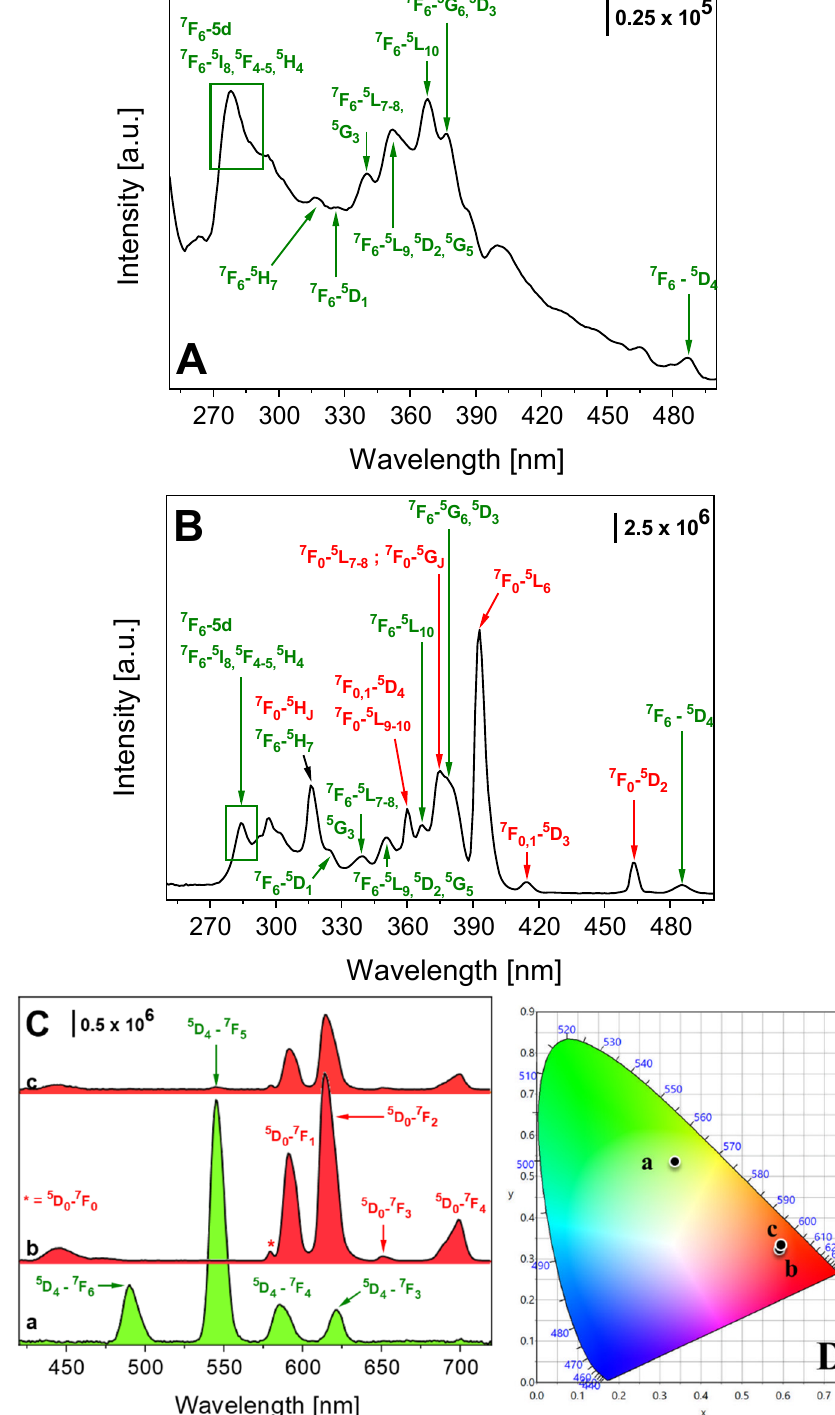
Figure 4. Excitation spectra at solid-state of TbEu-PhPOSS monitored at λ em = 545 nm ( A ) and λ em = 615 nm ( B ). ( C ) Emission spectra at solid-state of Tb-PhPOSS (a, λ exc = 285 nm) and TbEu-PhPOSS (b, λ exc = 395 nm, c, λ exc = 285 nm). The electronic transitions of terbium are marked in green colour, while those assigned to europium are in red, for more clarity. ( D ) CIE 1931 xy chromaticity diagrams derived from emission spectra in frame ( C ). The colour of each emission spectrum in frame ( C ) is associated with its corresponding xy coordinates (frame ( D ) and Table S2).